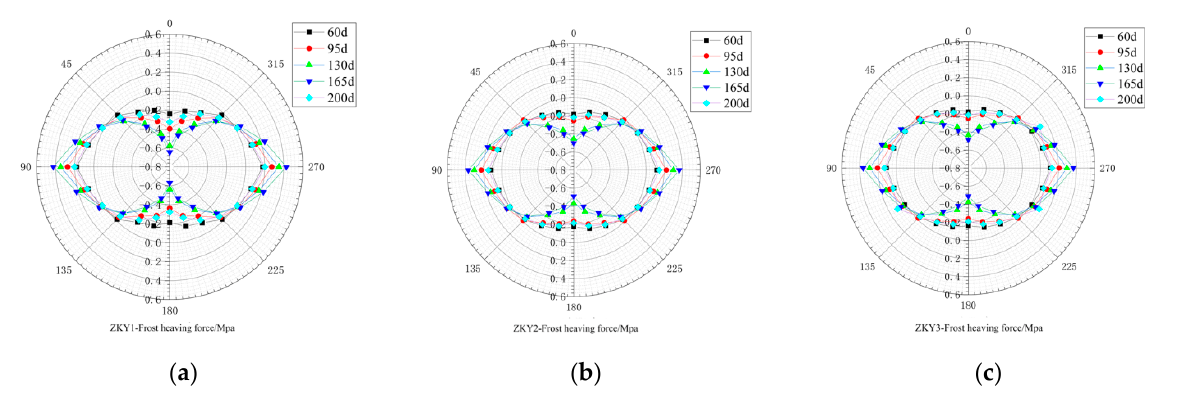
Figure 8. Variation of circumferential distribution curve of frost heaving force over time (unit: MPa). ( a ) ZKY1-frost heaving force. ( b ) ZKY2-frost heaving force. ( c ) ZKY3-frost heaving force. Variation of finite element calculation values of frost heaving force at arch top, arch waist and arch bottom over time and depth are shown in Figure 9, where positive frost